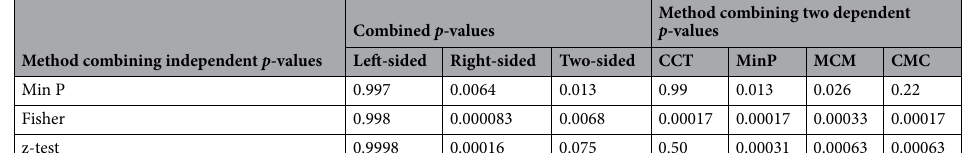
Method combining independent p